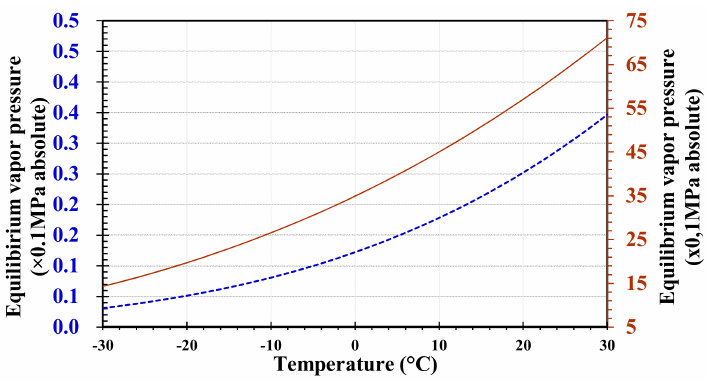
Figure 9. Saturating vapor pressure of fluoronitriles (left vertical axis) and CO 2 (right vertical axis) vs. temperature.